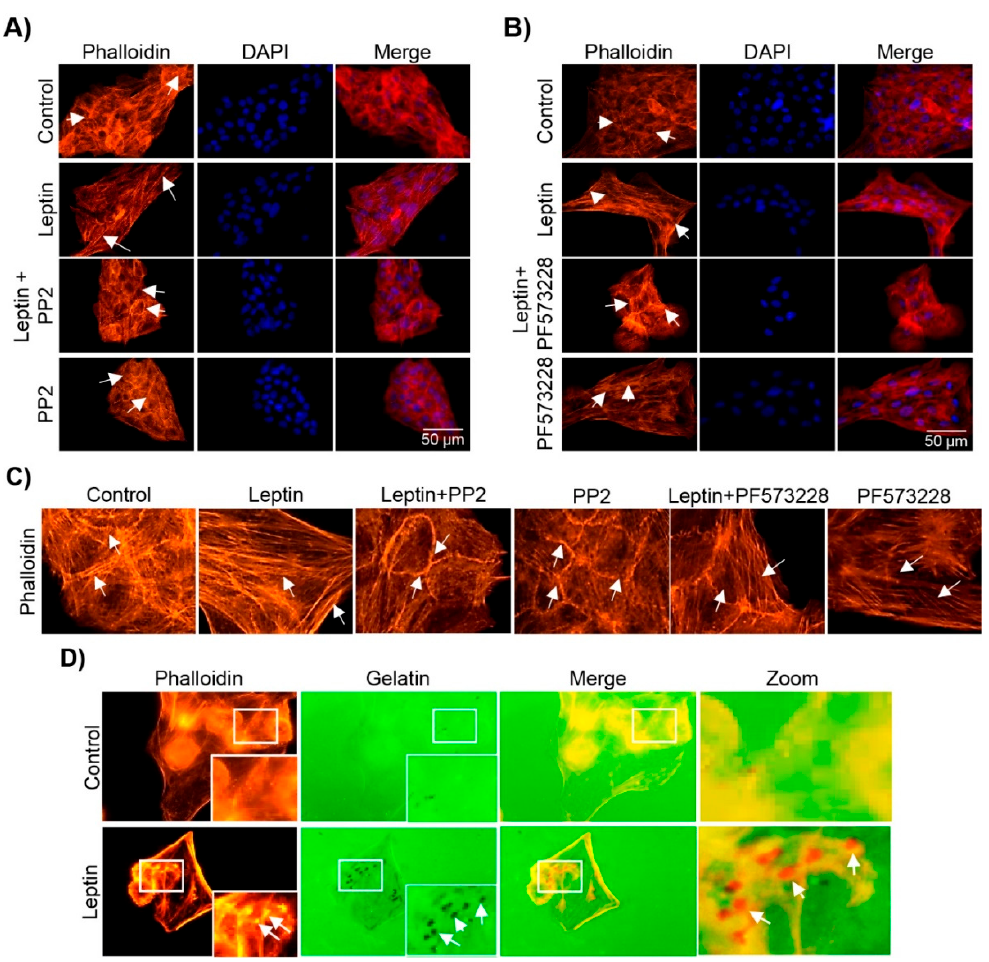
Figure 5. Leptin stimulation leads to the re-arrangement of the actin cytoskeleton and formation of invadopodia. Representative images of MCF10A cells pre-treated or not with PP2 ( A ) or PF-573228 ( B ) for 30 min and subsequently with leptin (400 ng/mL) for 24 h. Actin filaments were detected with Phalloidin-TRITC (red) and DNA was counterstained with DAPI. Images were acquired using the 40× magnification. ( C ) Enlarged images of actin cytoskeleton of MCF10A cells grown in the presence or absence of leptin, and the Src and FAK inhibitors. White arrows indicate structures of actin. ( D ) Representative images of invadopodia formation assays. Actin puncta was detected with phalloidin (red) and Alexa 488-labeled gelatin (green) was used as a specific substrate for the membrane-bound MMP-14 located at the edge of invadopodia. Arrows indicate areas of gelatin degradation. Images were acquired using a 100× magnification.